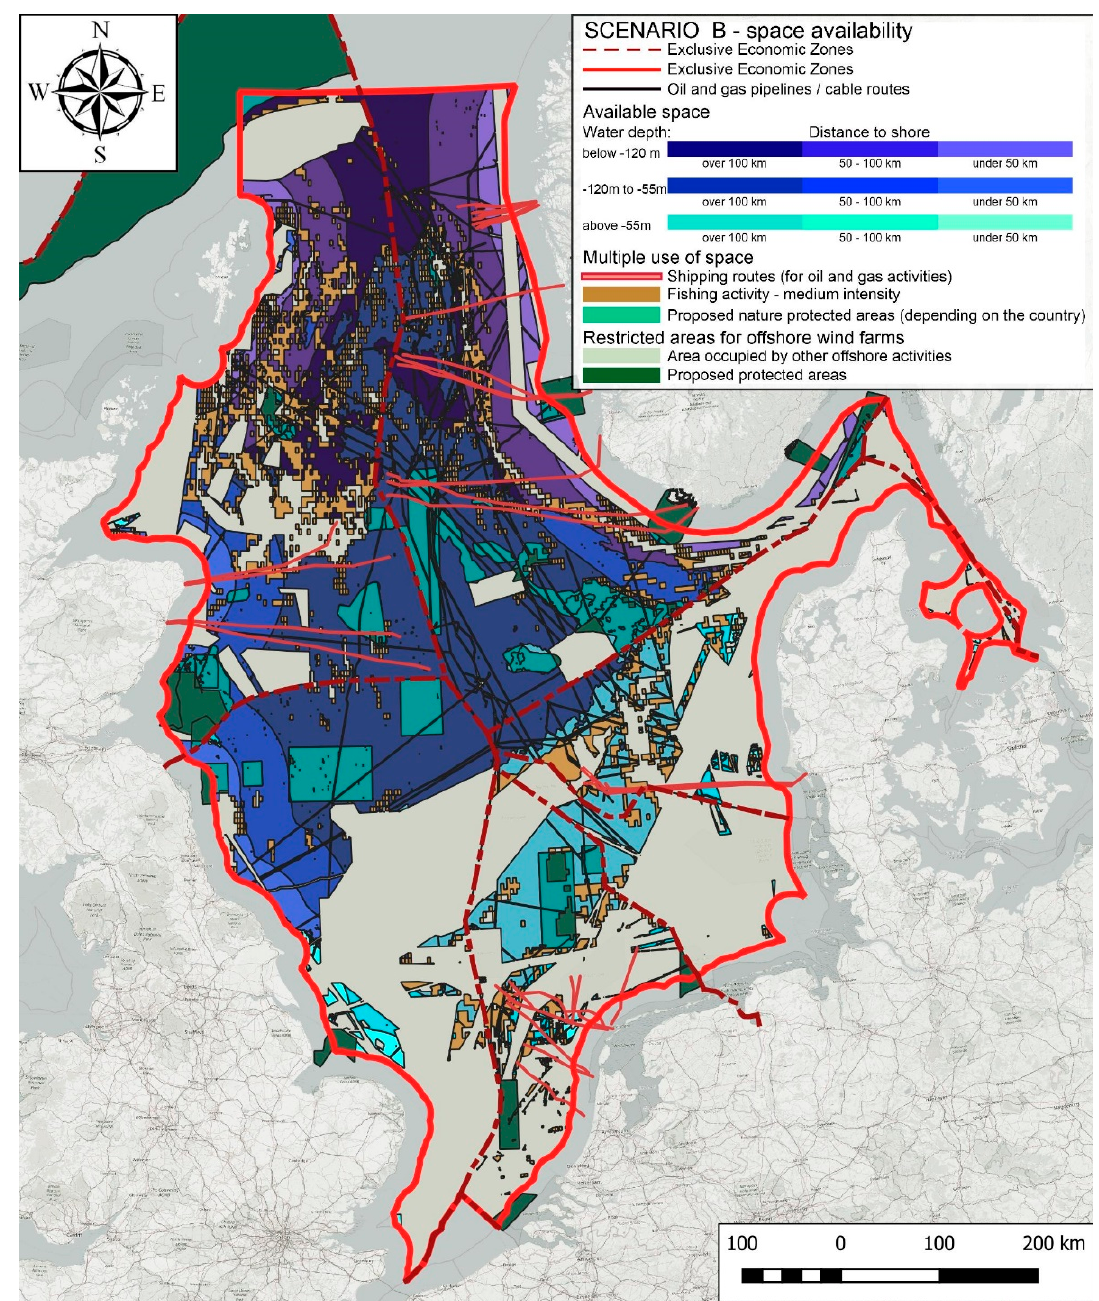
Figure 8. Scenario B: low renewable energy ambitions/integrated planning. Table 9. Available space—Scenario B.